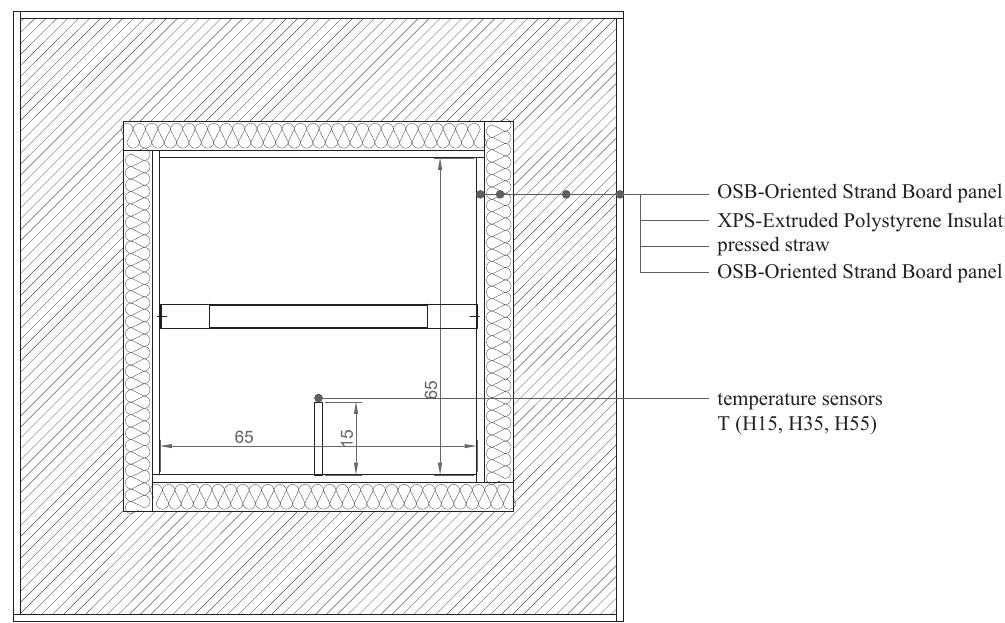
Figure 2. ( a ) Vertical and ( b ) horizontal sections of the refrigerator (dimensions in cm).